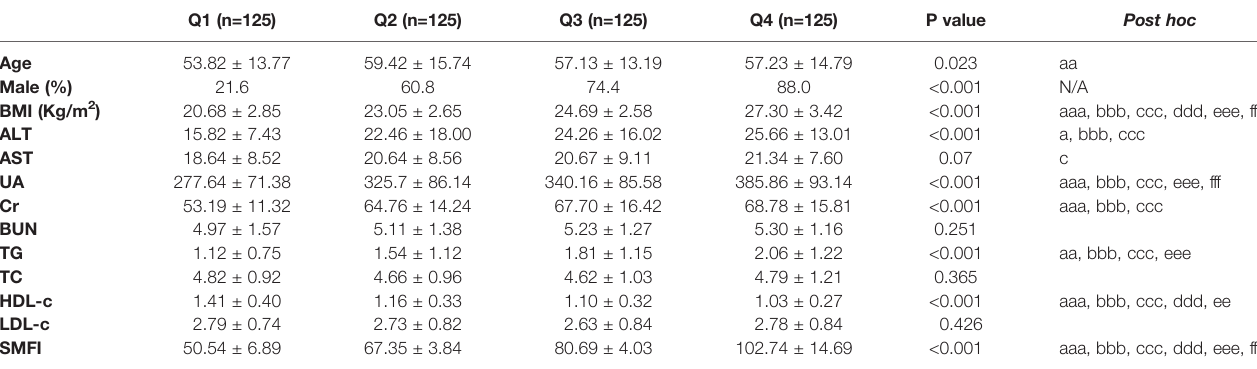
TABLE 1 | Characteristics of all subjects with different SMFI quartiles strati fi cation. Q1 (n=125) Q2 (n=125) Q3 (n=125) Q4